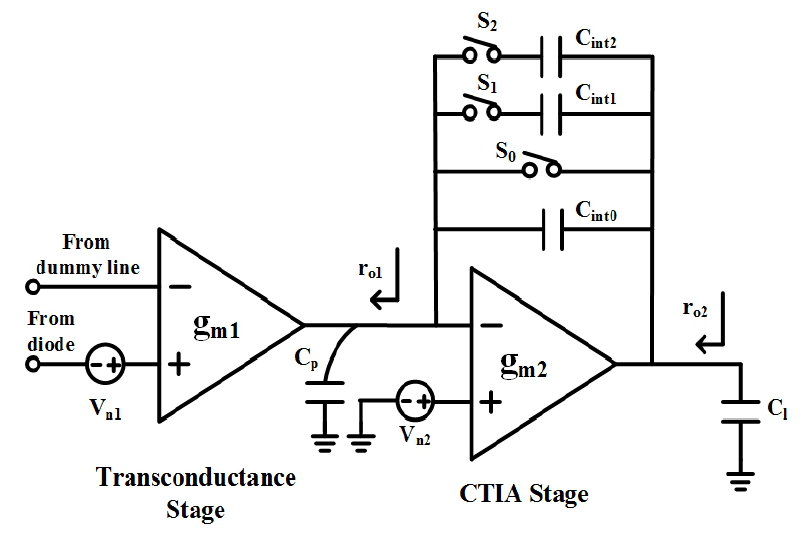
Figure 4. Differential integrator